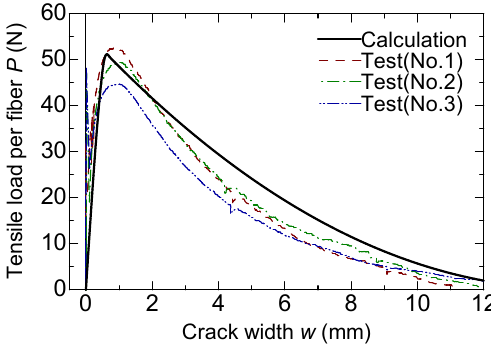
Figure 17. Comparison of bridging law.